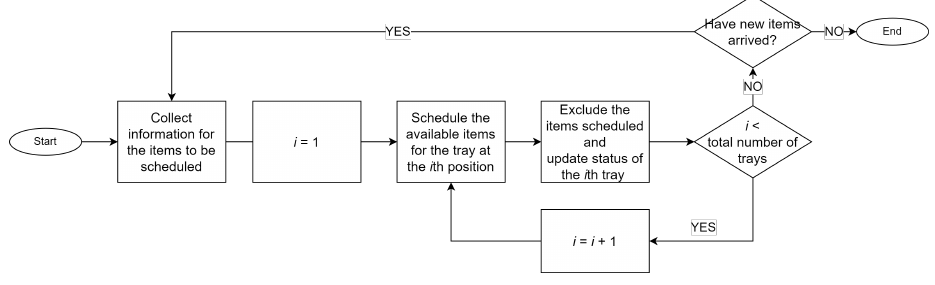
Figure 4. A flow chart of the proposed solution